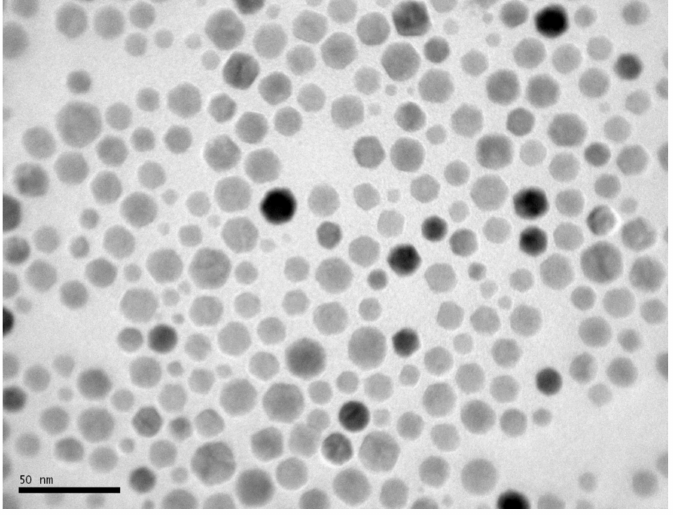
Figure 2. TEM micrograph from the oleate-coated MION